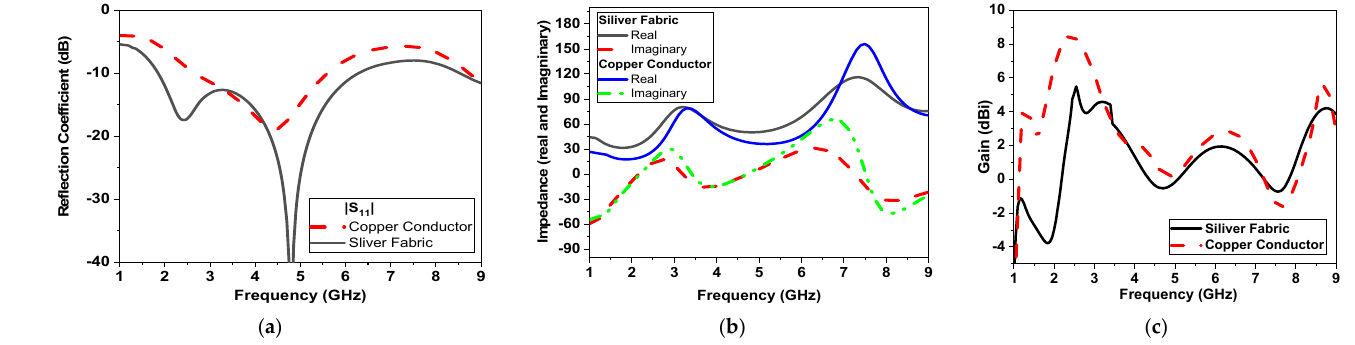
Figure 7. ( a ) Simulated reflection coefficient in dB, ( b ) simulated impedance (real and imaginary),